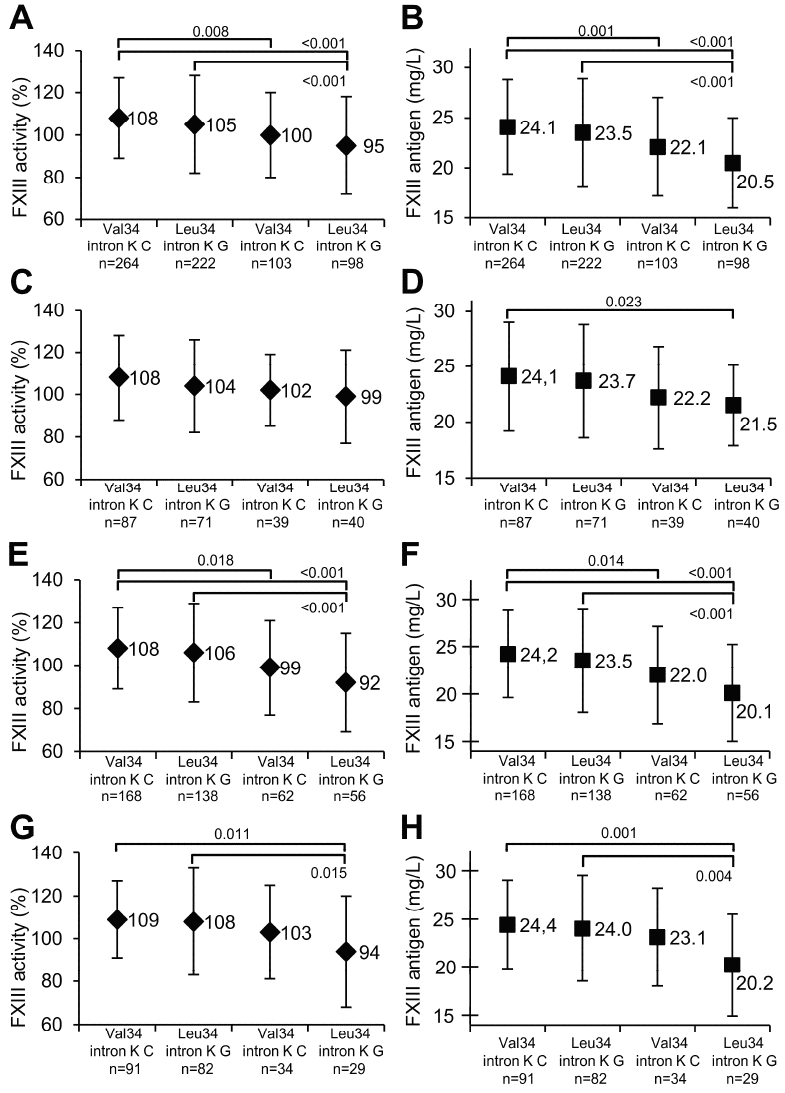
Figure 1. The effect of FXIII-A Val34Leu, FXIII-B intron K nt29756 C>G polymorphisms and their combination on FXIII activity and antigen levels. FXIII levels adjusted for gender, smoking, serum total cholesterol and plasma fibrinogen levels are expressed as the mean ± SD; the numerical values of the means are also shown. The combination of FXIII-A and FXIII-B alleles are shown on the abscissa; Val34 and intron K C represent homozygosity for the wild-type FXIII-A and FXIII-B alleles; Leu34 and intron K G represent carriers of the respective mutant allele. Significant differences between genotype combinations are indicated by the p- values associated with the horizontal lines on the upper part of the figure. FXIII activity ( A , C , E , G ) and antigen ( B , D , F , H ) levels are demonstrated in the whole study group ( A , B ), in the CAS − MI − ( C , D ), in the CAS+ ( E , F ) and in the MI+ ( G , H ) patient